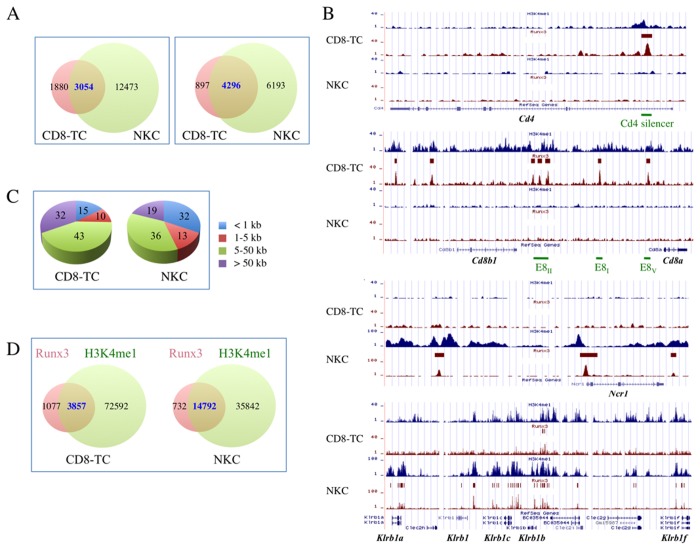
Genome-wide occupancy of Runx3 and H3K4me1 in resting CD8-TC and NKC.(A) Venn diagram summarizing the number of Runx3 ChIP-seq peaks (left panel) and corresponding annotated genes (right panel). (B) Runx3-bound and H3K4me1-marked regions in the Cd4, Cd8, Ncr1 and Klrb1a-Klrb1f loci. Brown and blue tracings reflect the Chip-seq tracing wiggle files uploaded to UCSC Genome Browser mm9 genome assembly of Runx3 and H3K4me1, respectively. Brown rectangles mark Runx3 peaks identified by MACS. Positions of the Cd4 silencer and some of the known Cd8 enhancers are marked in green. (C) Pie chart showing the % of Runx3-bound regions relative to the nearest TSS. (D) Overlap of Runx3-bound and H3K4me1-marked regions.